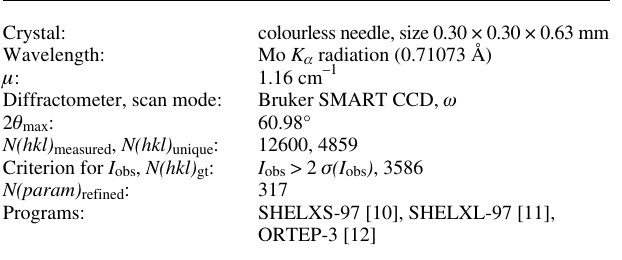
Table 1. Data collection and